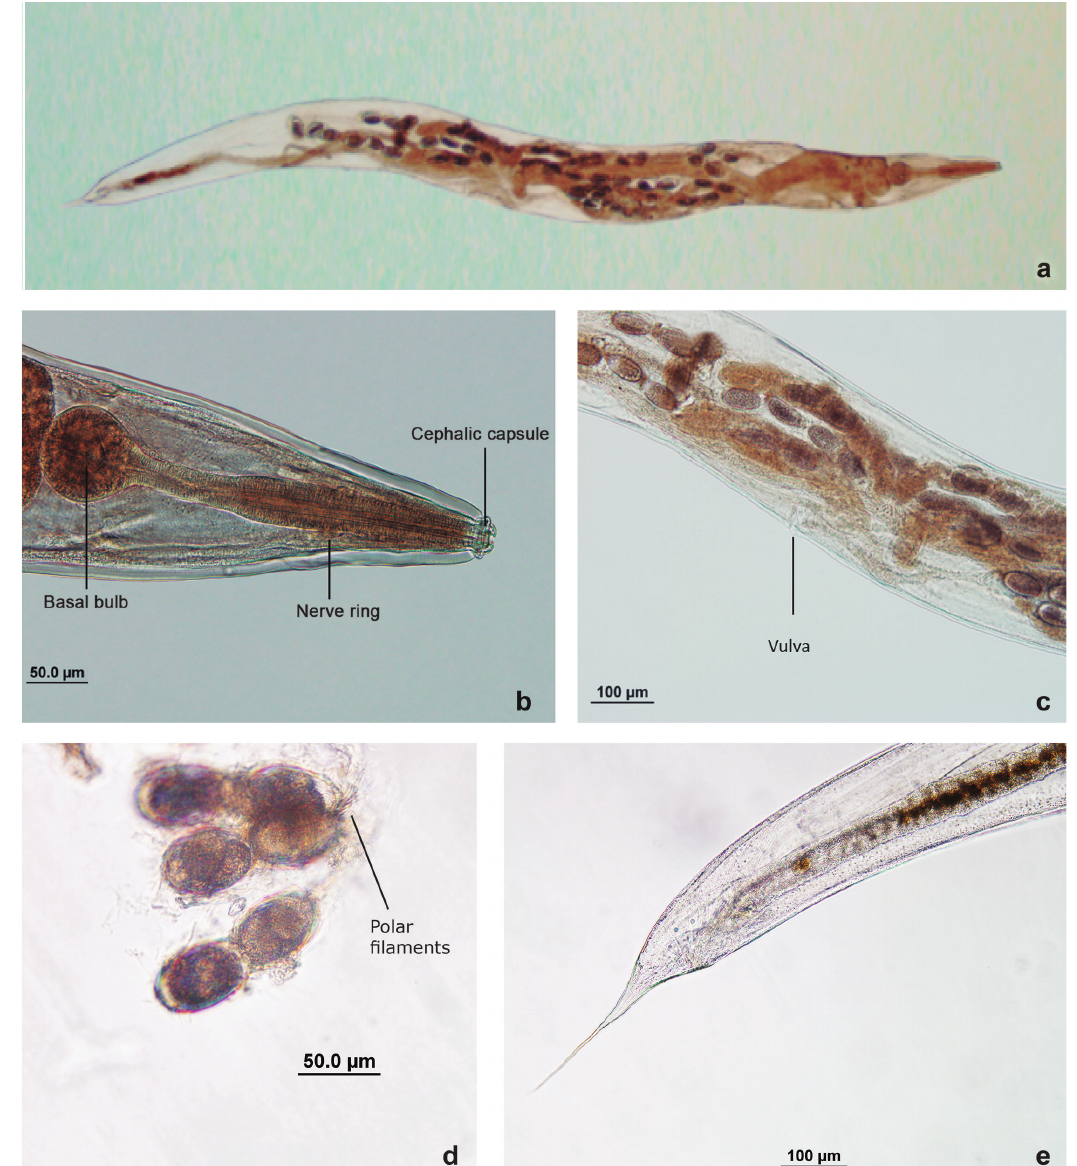
Figure 3 - Binema klossae . a. Female, entire. b. Cephalic region (lines showing the cephalic capsule, nerve ring and basal bulb). c. Vulval region (line showing the vulva). d. Eggs with polar filaments. e. Posterior